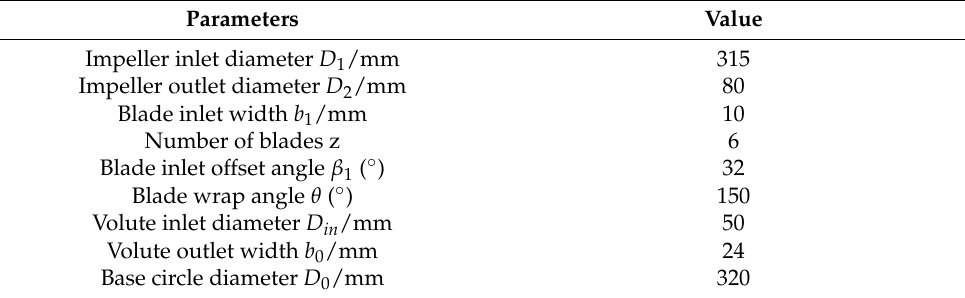
Table 1. Main structure dimensions of PAT.